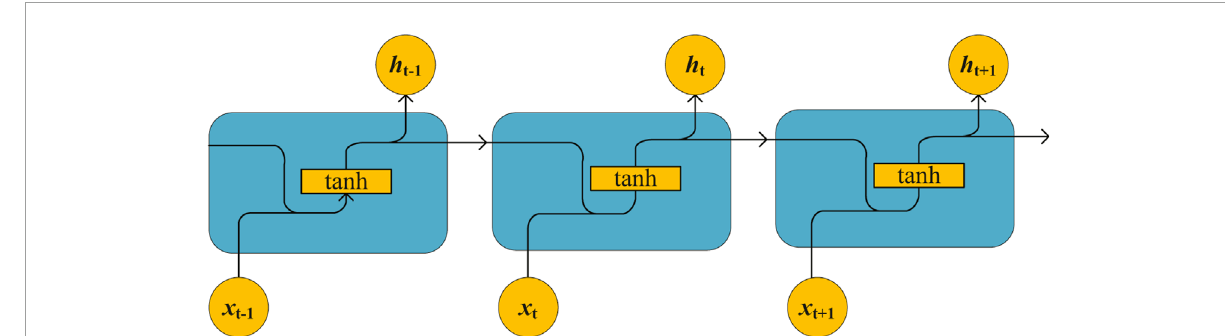
FIGURE 2 The chain of RNN.